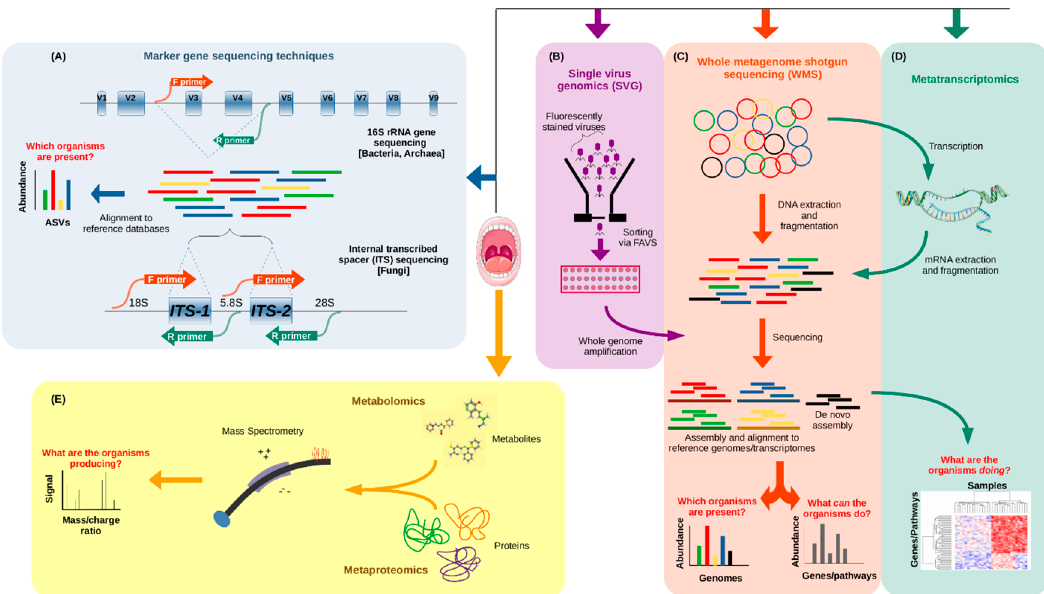
Figure 1. Schematics of standard techniques used in microbiome studies. ( A ) Marker gene sequencing techniques can use primers to target certain conserved regions of a genome to capture intermittent variable regions, which can then be used to identify organisms in a sample rapidly and inexpensively. The 16S rRNA gene is the most commonly used marker gene in bacteria and archaea, and in the figure, primers are used to capture the V3 and V4 variable regions together, a common approach for 16S sequencing. The internal transcribed spacer (ITS) region of the nuclear rRNA cistron in fungi is made of two segments, which can be captured with primers targeting the 18S, 5.8S, and 28S rRNA sections that surround them. ( B – D ) Instead of targeting one small segment of the genome, these techniques capture the entirety of the genetic material from an organism. ( B ) Single virus genomics (SVG) uses a fluorescent stain to isolate individual virus particles in a sample by fluorescence-activated virus sorting (FAVS), wherein they are embedded in an agarose bead before undergoing whole genome amplification